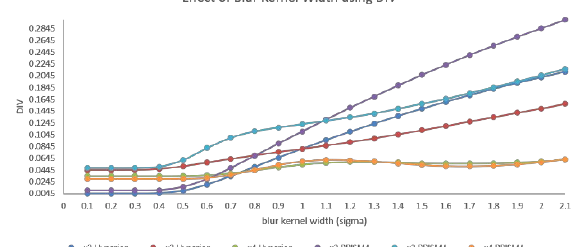
Figure 17. Effect of Blur Kernel Width Using DIV on GPR’s Performance DIV values are positive, increasing with rising kernel size and σ. The sharpest rise is in the case of x2 PRISMA from σ = 0.5 onwards. For x3 PRISMA the rise in values begins from σ = 0.4 in a concave shape till σ = 1.1 and then rising slowly to match the DIV values of x2 Hyperion from σ = 1.8 onwards . x4 Hyperion and x4 PRISMA almost overlap each other with rising kernel size and σ. Again σ = 0.1 shows the lowest DIV for each SF irrespective of the dataset